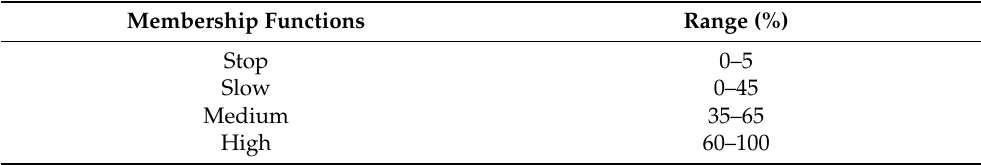
Table 6. Membership Functions for the